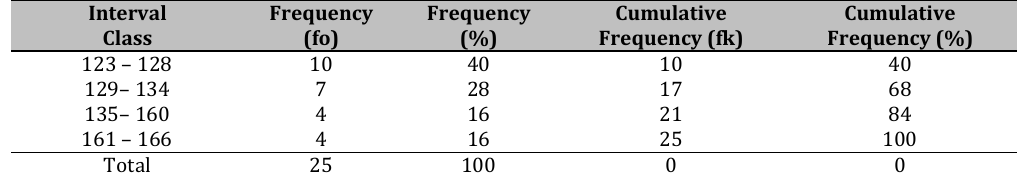
Table 4 Frequency Distribution of Relevance of Teachers’ Performance before Using Academic Supervision Guidebook